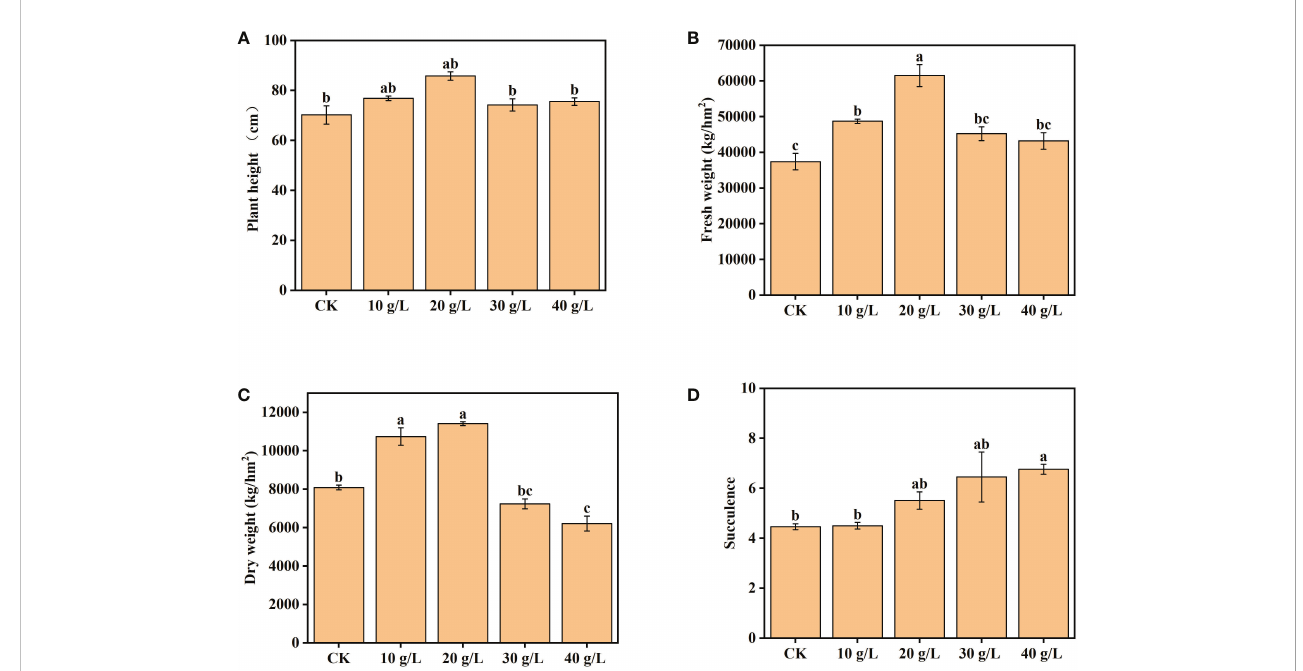
signi fi cance was determined at the 5% signi fi cance level. All results are presented as means plus or minus the standard error (SE). Histograms were drawn using OriginPro 2021